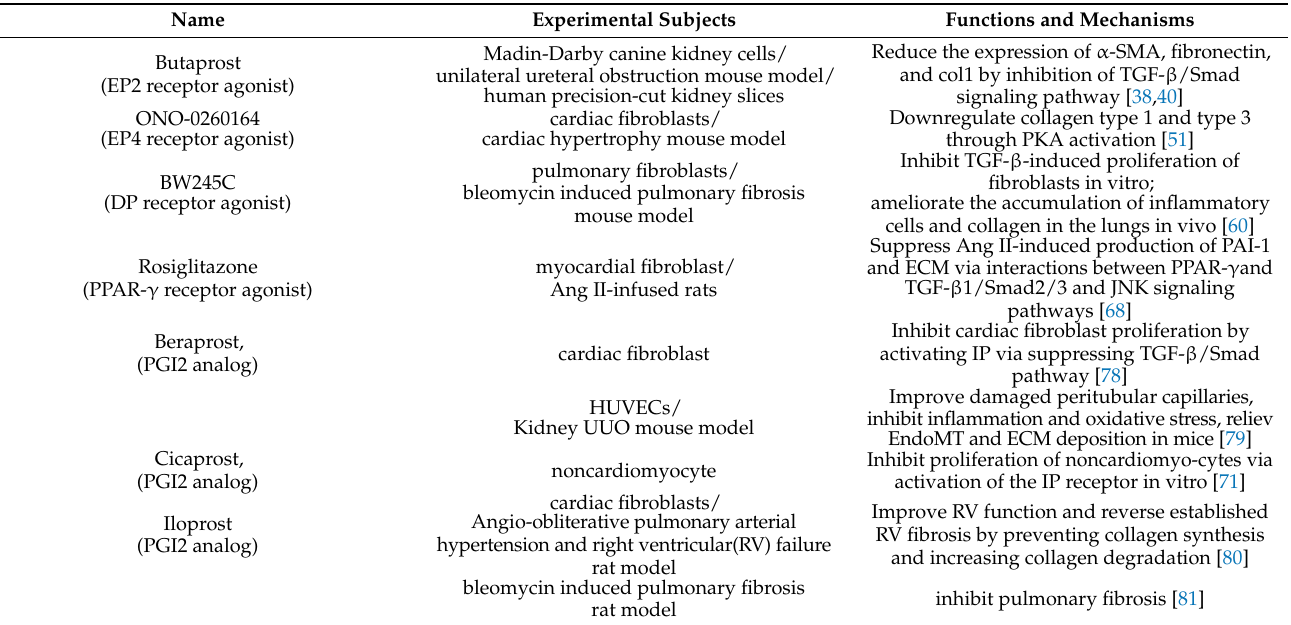
Figure 3. The pto-fibrotic effects of PGF2 α and TXA2. PGF2 α acts on the FP receptor on the surface of fibroblasts to induce cell proliferation and collagen expression by activating PKC/Rho kinase—ROCK (Rho-associated kinase) pathway. TXA2 secreted by platelets acts on TP receptors and promotes fibrosis by activating cAMP signaling. Table 2. Effects of analogs or receptor agonists/antagonists of PGs on fibrosis.